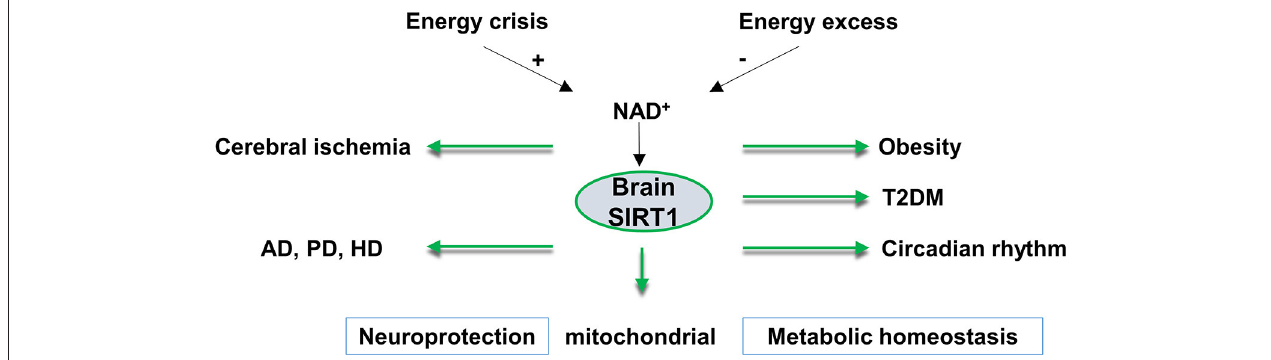
FIGURE 1 | An overview of brain SIRT1 in metabolic and neurological disorders. Brain SIRT1 activity is dependent on NAD + levels, which increases under energy crisis, and decline with high energy load. Any dysregulation of brain SIRT1 activity can have devastating consequences in terms of mitochondrial function, metabolic homeostasis, circadian synchronization, and neurological function. A proper function of brain SIRT1 is protective against obesity, diabetes, circadian dysregulation. In addition, brain SIRT1 exerts neuroprotection against ischemic injury and neurodegenerative disorders, such as Alzheimer’s disease (AD), Parkinson’s disease (PD), and Huntington’s disease (HD). T2DM, type 2 diabetes, NAD + , nicotinamide adenine